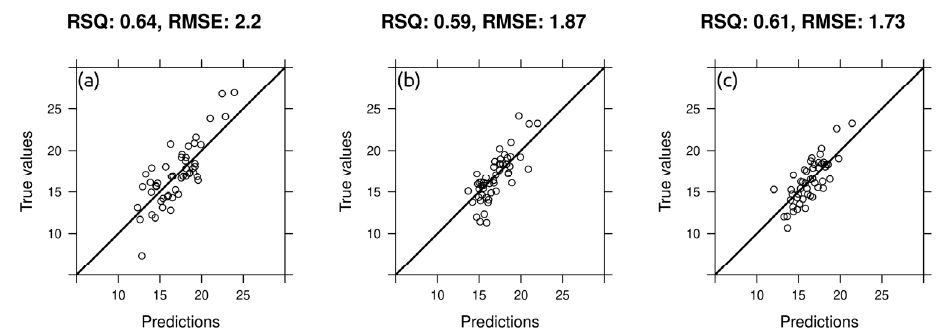
Figure 8. “Predicted versus measured” plots for best models based on spatial cross validation: ( a ) best model for 0–15 cm gravimetric soil moisture; ( b ) best model for 15–30 cm gravimetric soil moisture; ( c ) best model for 30–45 cm gravimetric soil moisture. Black bold line = 1:1 line. RSQ = R 2cv .